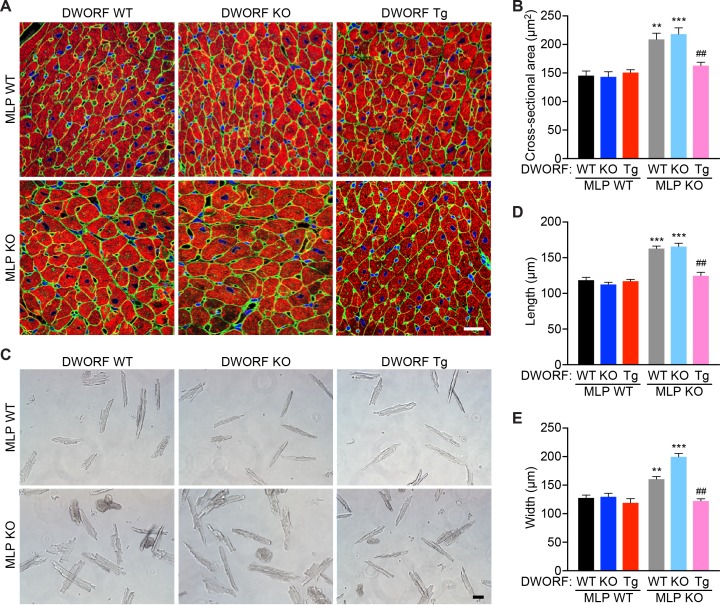
Overexpression of DWORF in MLP KO mice prevents cardiomyocyte hypertrophy.(A) Representative confocal images of heart sections from 8-week-old mice with the indicated genotypes. Immunostaining was performed for wheat germ agglutinin (WGA, green), cardiac troponin T (red) and nuclei were stained with DAPI (blue). All images were taken of the LV-free wall at mid-level. Scale bar is 20 µm. (B) Quantitative analysis of cardiomyocyte cross-sectional area from n = 5 mice of each genotype. Mean data are represented as bar graphs (±SD). p-value **p<0.01 or ***p<0.005 vs. WT and ##p<0.01 vs. MLP KO. (C) Bright field images of freshly isolated adult mouse ventricular cardiomyocytes from 8-week-old mice with the indicated genotypes. Scale bar is 20 µm. (D, E) Cardiomyocyte length (D) and width (E) were quantified using ImageJ software and mean values are shown for n = 4 mice of each genotype (±SD). p-value **p<0.01 or ***p<0.005 vs. WT and ##p<0.01 vs. MLP KO. Statistical comparisons between groups were evaluated by Student’s t-test.